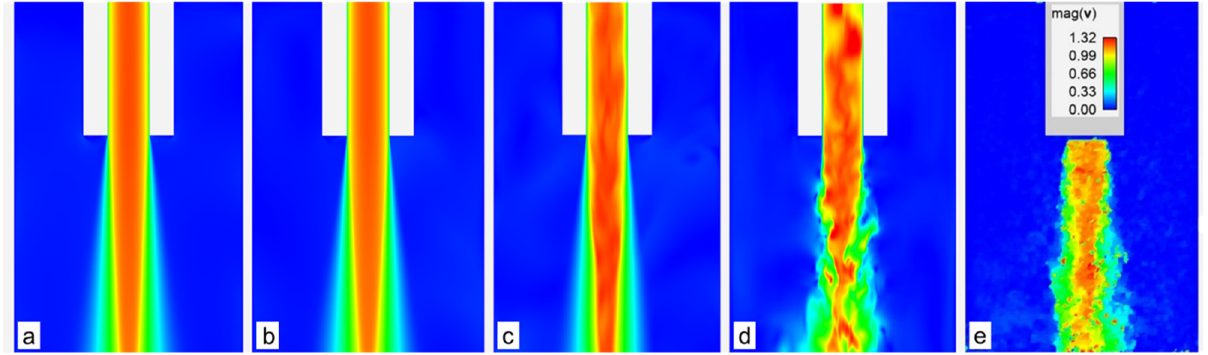
Figure 5. Contours of velocity magnitude in the y-z plane at z = 0 (middle of the SEN) for A1 ( a ), A2 ( b ), A3 ( c ), A4 ( d ), and experiment ( e ).